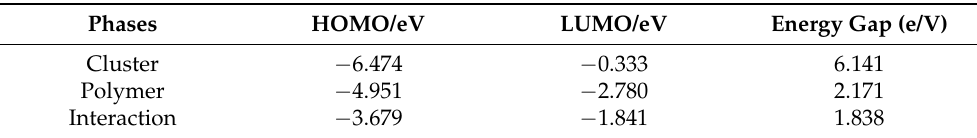
Table 1. HOMO–LUMO energy and energy gap of the studied compound according to DFT at wB97XD/6-311++G(d,p). Phases HOMO/eV LUMO/eV Energy Gap (e/V) Cluster